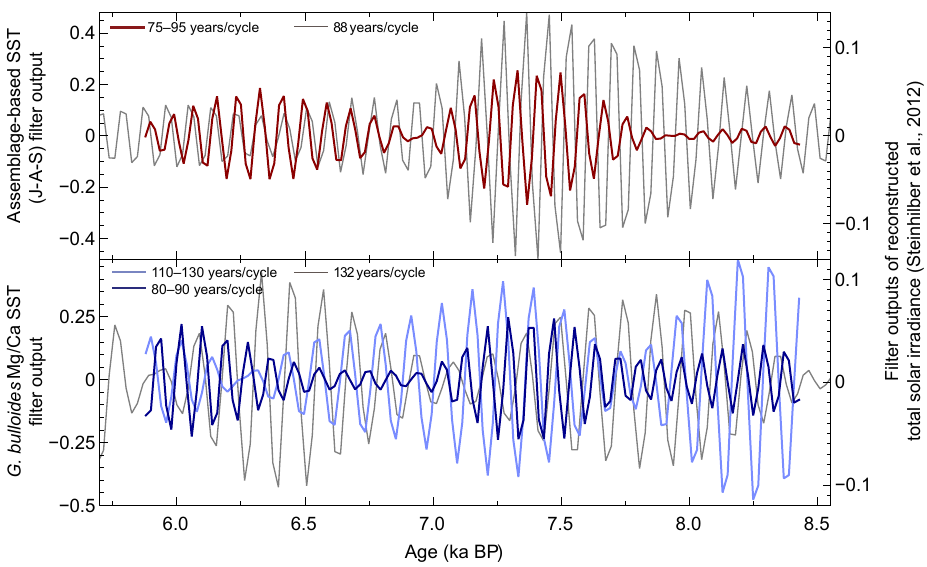
Figure 9. Comparison of filtered assemblage-based SST (red line, upper panel) and G. bulloides Mg / Ca SST (blue lines, lower panel) with filtered reconstructed total solar irradiance (TSI) from Steinhilber et al. (2012) (grey lines); 88 years per cycle are illustrated in the upper panel and 132 years per cycle in the lower panel. Filtered components were extracted using a Gaussian band-pass filter with a central frequency of 0.0118 cycles year − 1 ( ∼ 85-year cycle) and 0.0083 cycles year − 1 ( ∼ 120-year cycle), respectively, and a bandwidth of 0.001 cycles year − 1 using the program AnalySeries 2.0.8 (Paillard et al.,